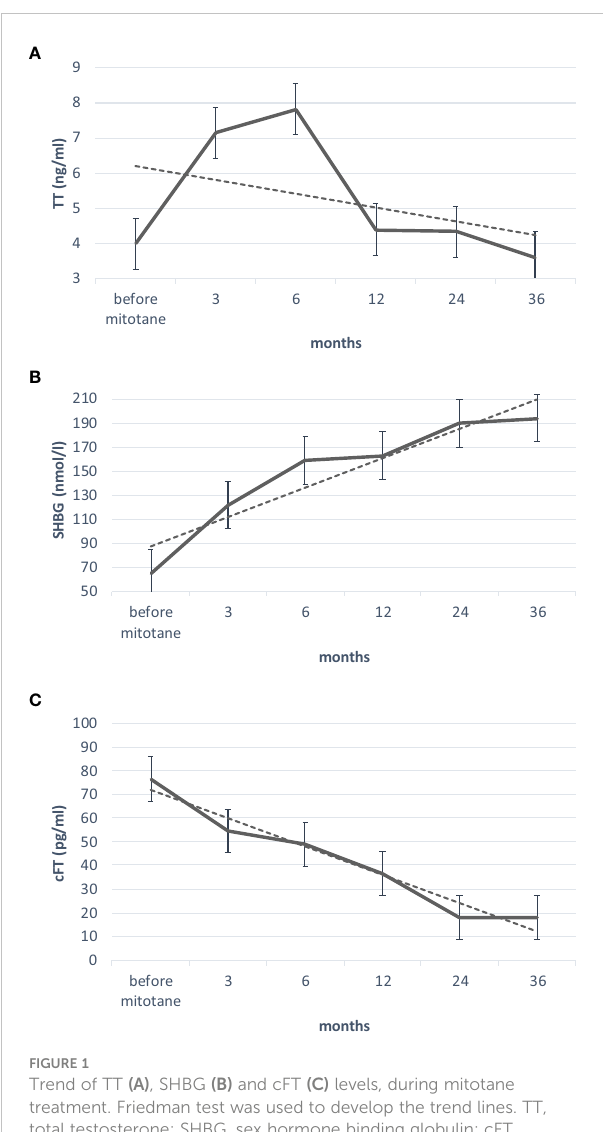
FIGURE 1 Trend of TT (A) , SHBG (B) and cFT (C) levels, during mitotane treatment. Friedman test was used to develop the trend lines. TT, total testosterone; SHBG, sex hormone binding globulin; cFT, calculated free testosterone. Trend lines in